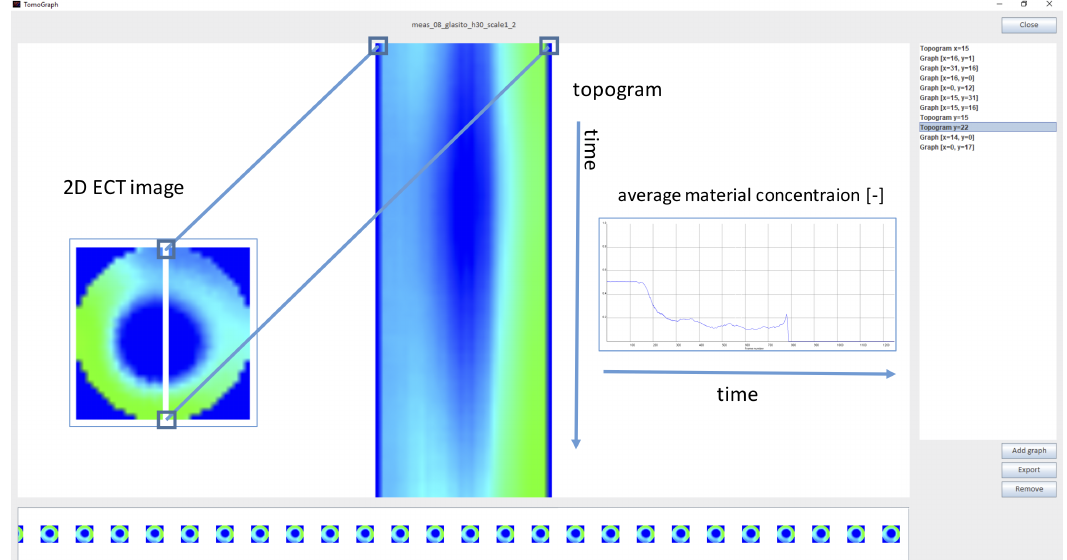
Figure 9. Illustration of how the system supports visualization and analysis transitionally, switching from 2D cross-sectional image space to a 2D temporal image (topogram) and back to the time plot diagram for a particular time point of